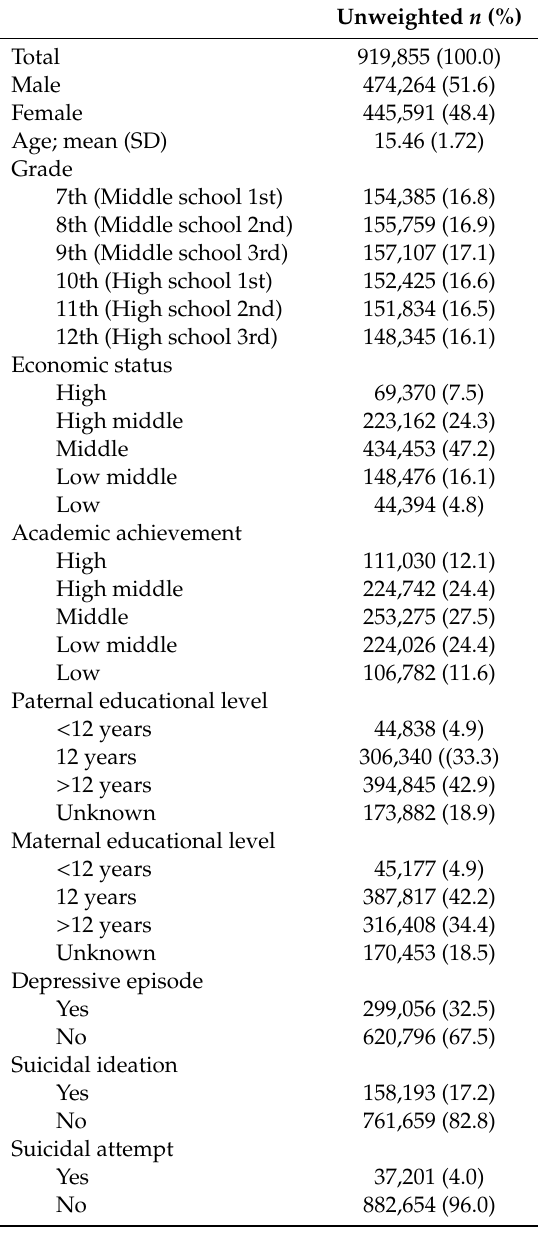
Table 1. Demographic